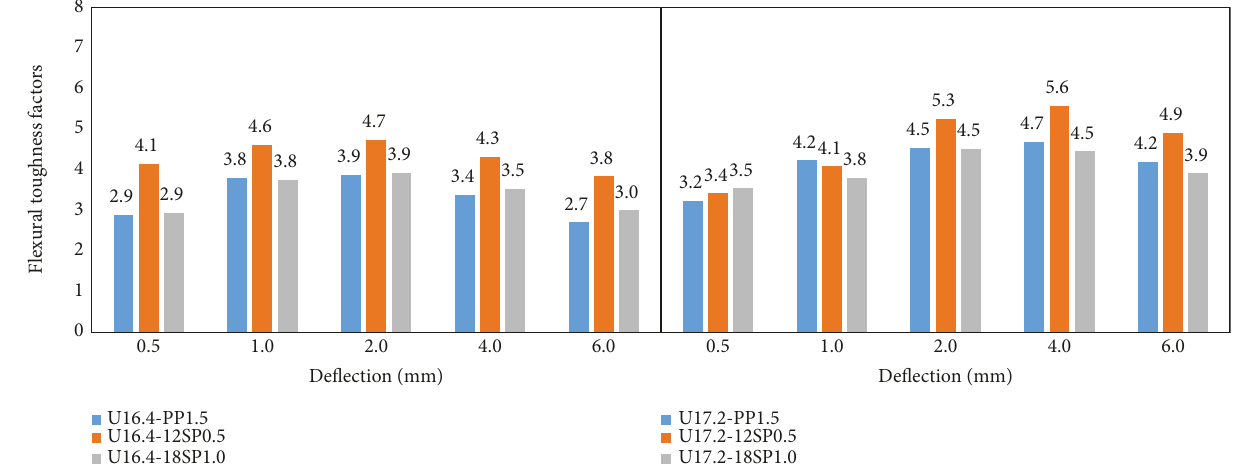
Figure 6: Flexural toughness factors calculated according to the curve in Figure 4 (FT